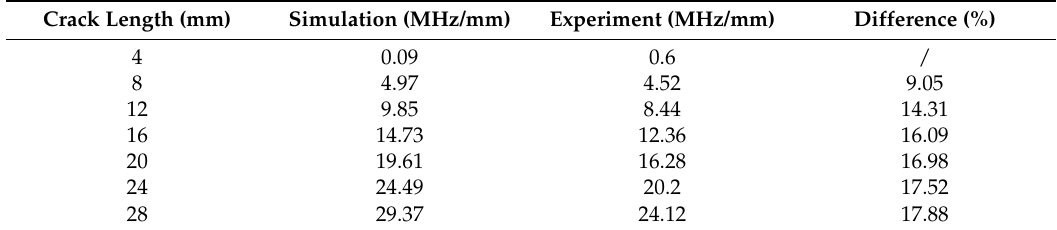
Table 2. Crack detection sensitivity of antenna sensor.